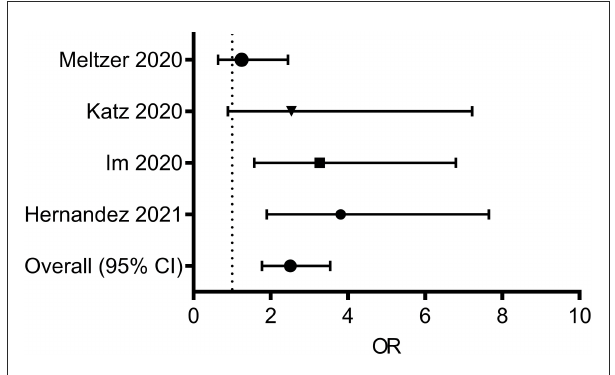
FIGURE2 Forest plot from random effects analysis: Vitamin D status (Low serum 25OHD, daily dietary intake) and COVID-19 infection rate. ORs of having vitamin D deficiency in the COVID-19 group vs. the control group. 25OHD, 25-hydroxyvitamin D; COVID-19, coronavirus disease 2019; ORs, odds ratio.